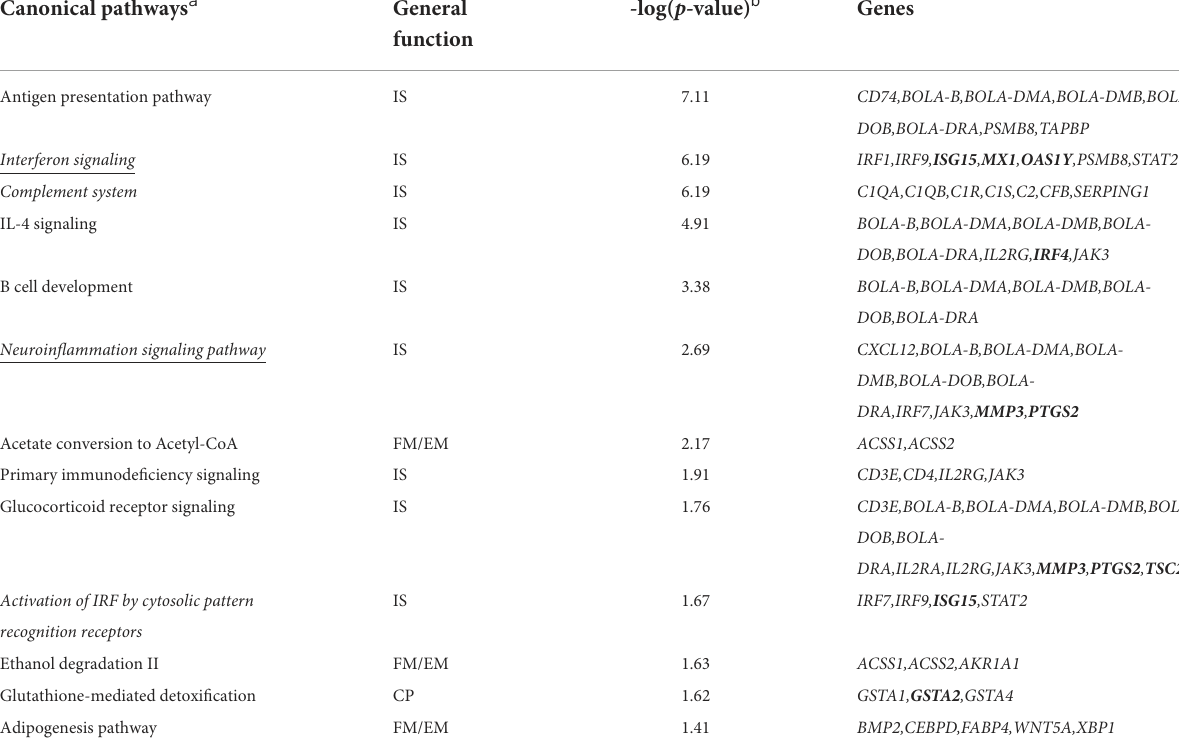
TABLE 3 Significantly enriched pathways in rumen tissue comparing HMUg and LMUg